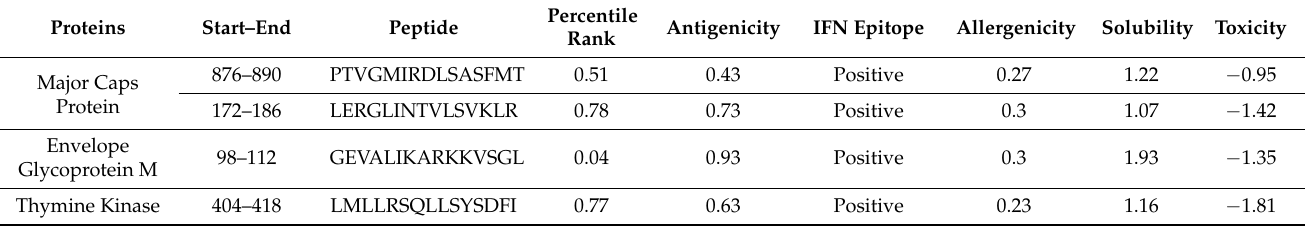
Table 3. Selected HTL epitopes with respective binding affinity and physiochemical